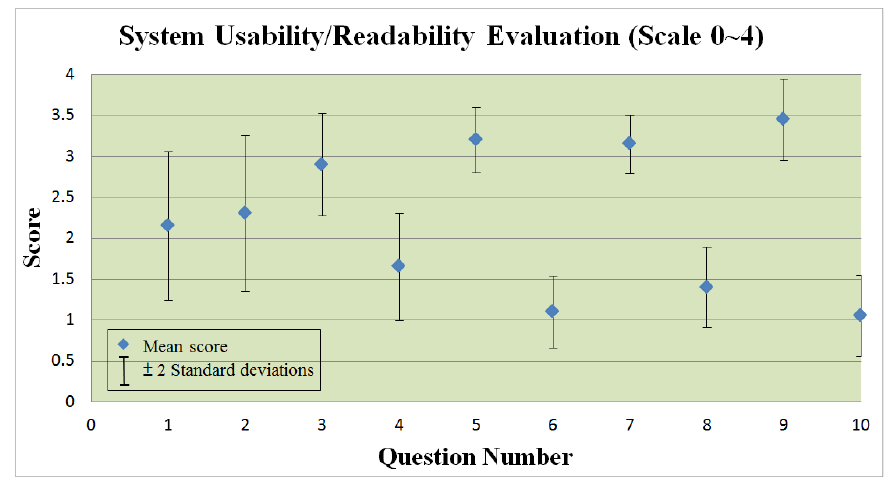
Figure 17. System usability/readability evaluation for health-care professional